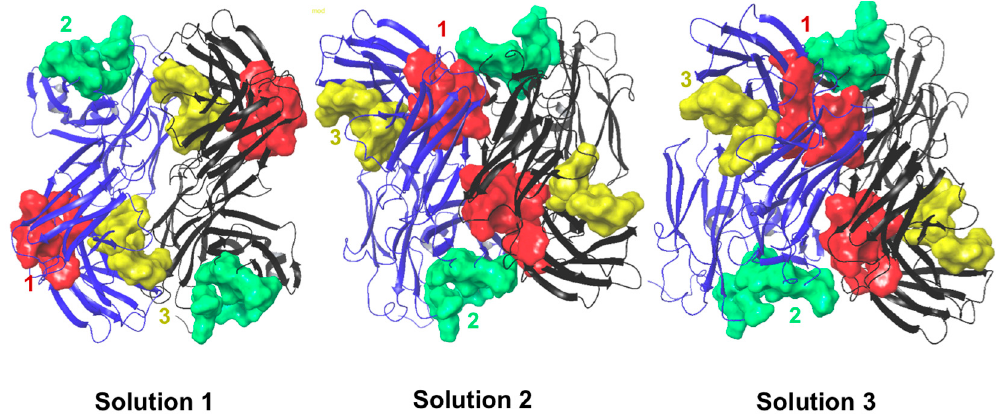
Figure 11. Docking solutions for interaction between two A33 molecules obtained with Hex. The A33 molecule defined as target is displayed in blue ribbons, and the molecule defined as ligand in grey. The hotspot surfaces are shown for both molecules and coloured according to the following scheme (Hotspot 1— red ; Hotspot 2— green ; and Hotspot 3— yellow ). Table 6. Correlation between the three hotspots identified and the three slower energy solutions of the molecular docking for two A33 molecules. Solution 1 Solution 2 Solution 3 Chain with higher number of interactions Heavy Light Light Matching hotspots 3 (light and heavy chain) 1 (light and heavy chain) 1 (light and heavy chain) and 2 (light chain)